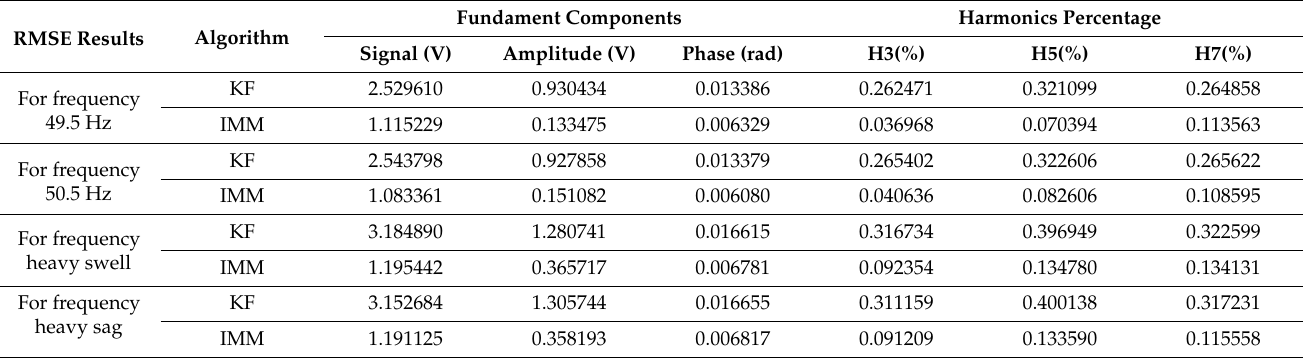
Figure 10. Simulation RMSE results for voltage frequency slight fluctuations. ( a ) RMSE results for frequency 49.98 Hz; ( b ) RMSE results for frequency 50.02 Hz; ( c ) RMSE results for frequency swell; ( d ) RMSE results for frequency sag. Table 2. Simulation RMSE results for voltage frequency heavy fluctuations.